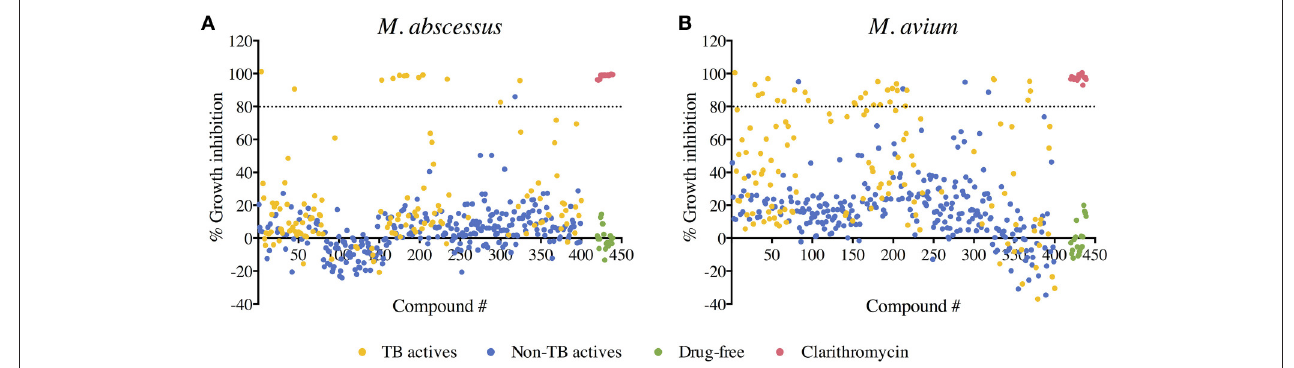
FIGURE 1 | Primary screen: compound—growth inhibition scatter plot for (A) M. abscessus and (B) M. avium . A total of 400 compounds from the Pathogen Box were screened for growth inhibition at 20 µ M against M. abscessus and M. avium . Out of the 400 test compounds, 129 are TB actives (shown in yellow) and 271 are non-TB actives (shown in blue). Drug free controls are shown in green and positive drug controls (Clarithromycin) are shown in red. Average % growth inhibition of duplicate data points for each compound is shown. Compounds with equal to—or more than—80% growth inhibition activity (above the black dashed line) were defined as hits.